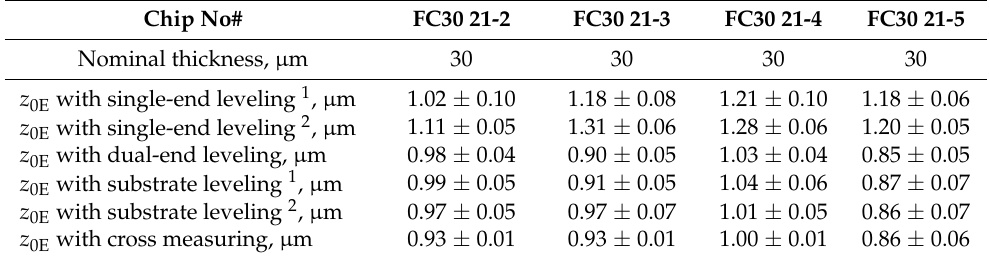
Table 6. The zero-load bending of microforce standards measured by a Fizeau interferometer.